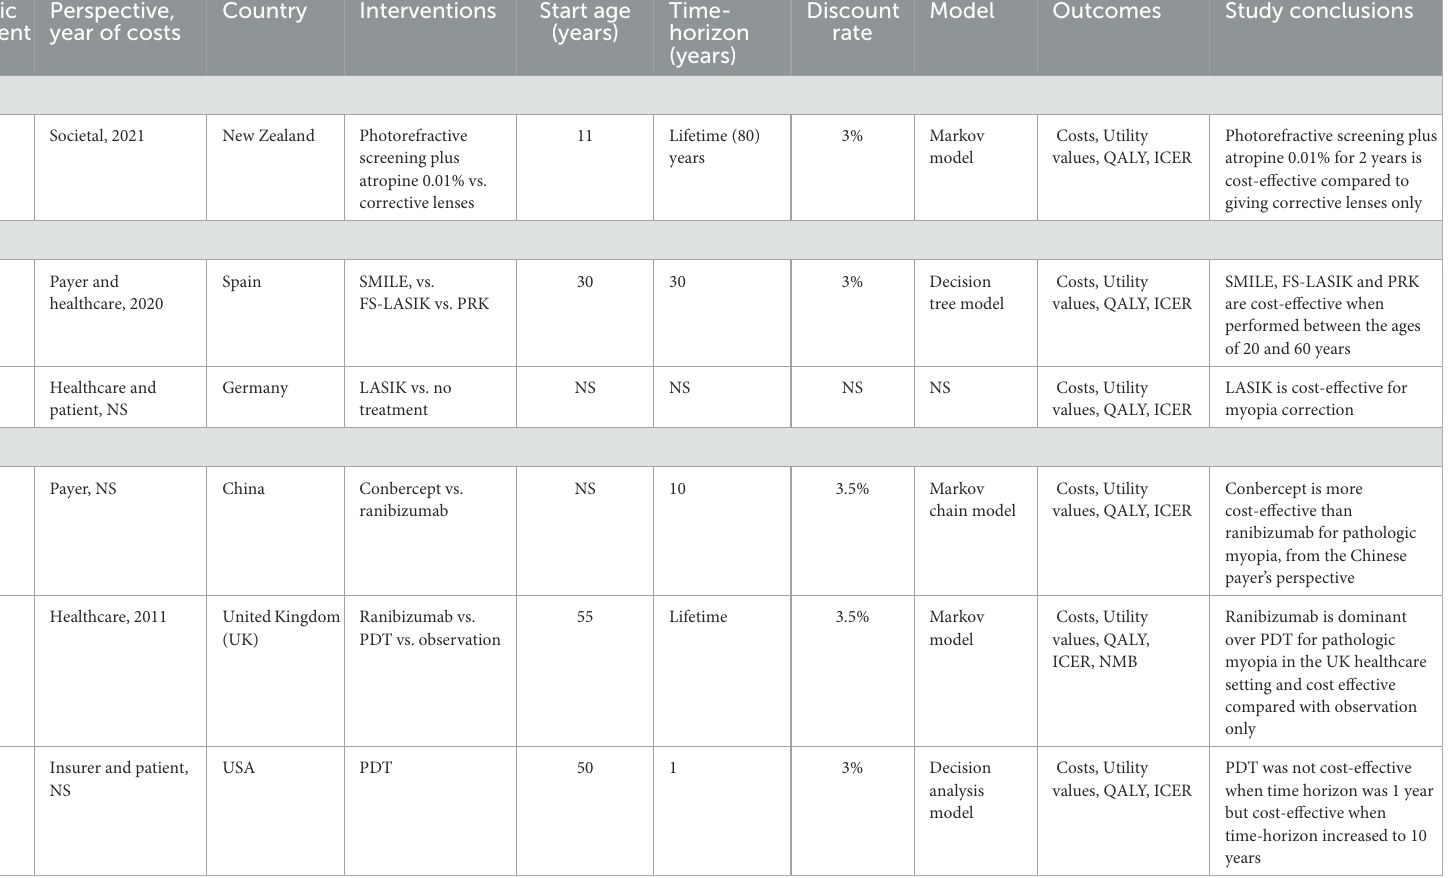
TABLE 1 Summary of included